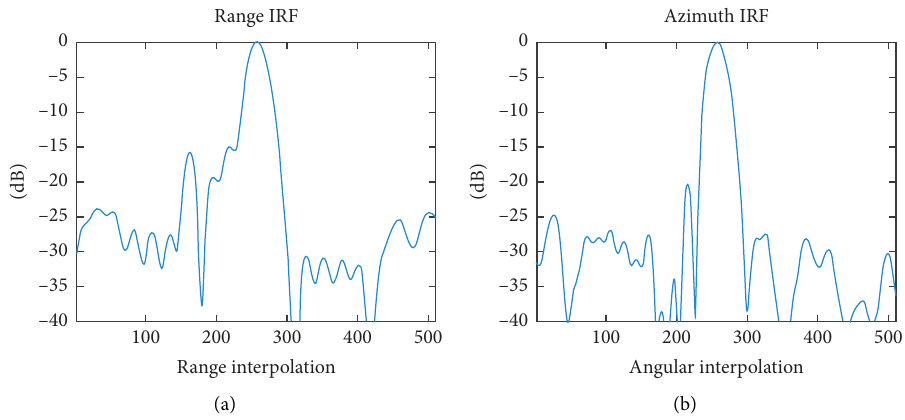
Figure 12: Two-dimensional IRFs of the reflector in circle “3”. (a) Range IRF. (b) Azimuth